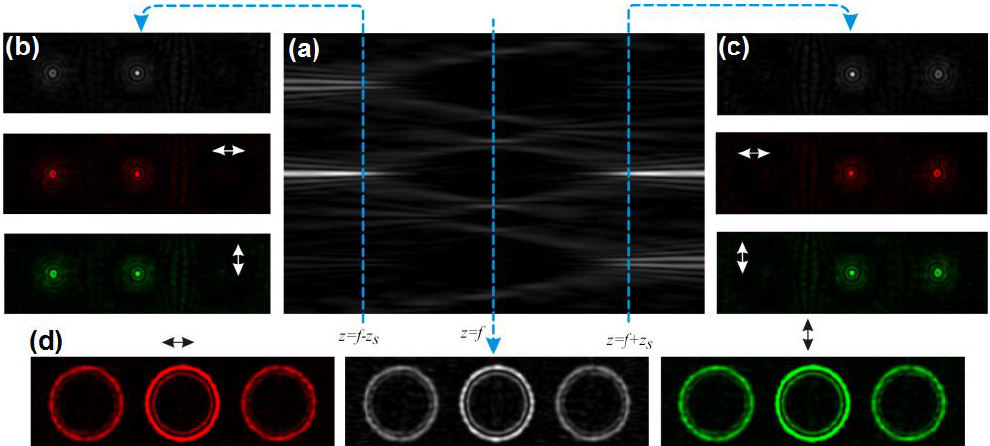
Figure 3. Spatial distributions for a combination of a lens and a binary DOE with transmission function calculated by Equation (7) in the case of circular «+»-polarization (red color corresponds to x -component, green color corresponds to y -component): ( a ) longitudinal field distribution in focal domain; ( b ) and ( c ) transversal field distribution at axis before ( z = f − z s ) and after ( z = f + z s ) focal plane, respectively; ( d ) transversal field distribution in the focal plane ( z = f ).